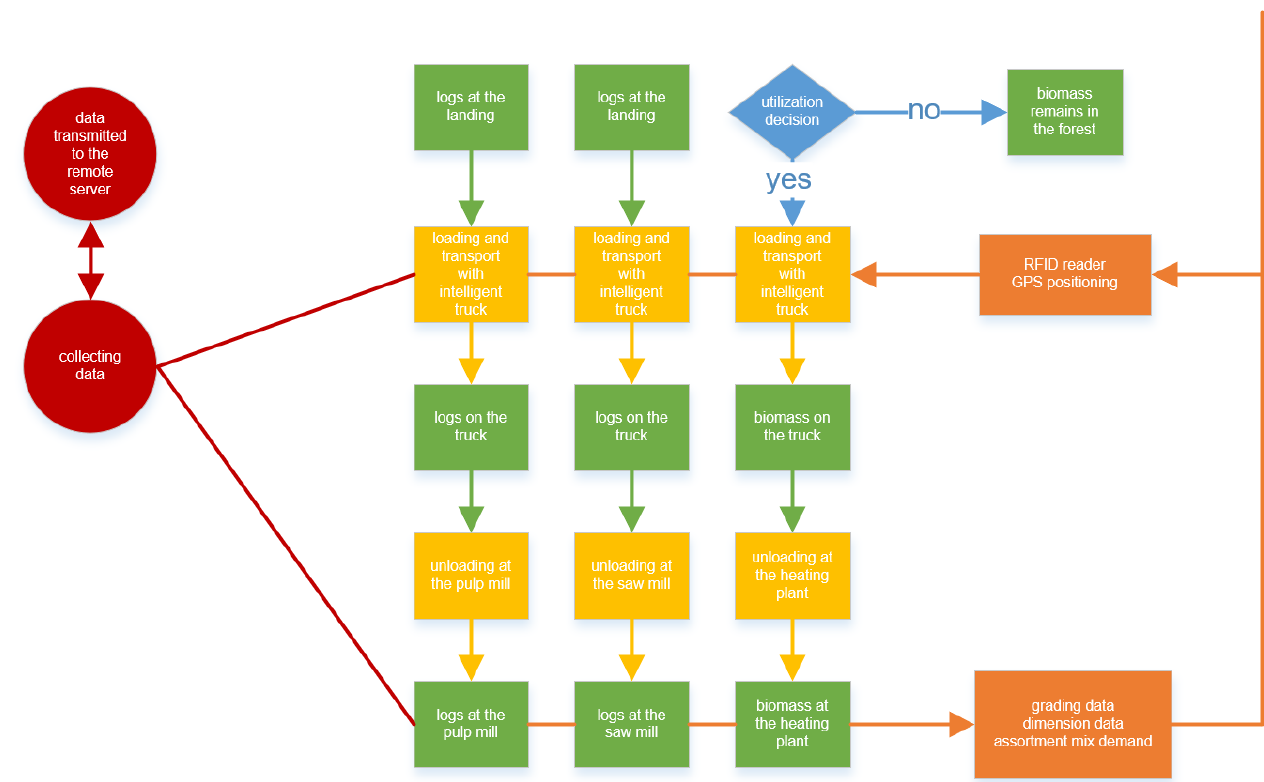
Figure 11. Flow chart “ Logs/Biomass at the Landing – Logs/Biomass at the Mill/Heating P lant” .